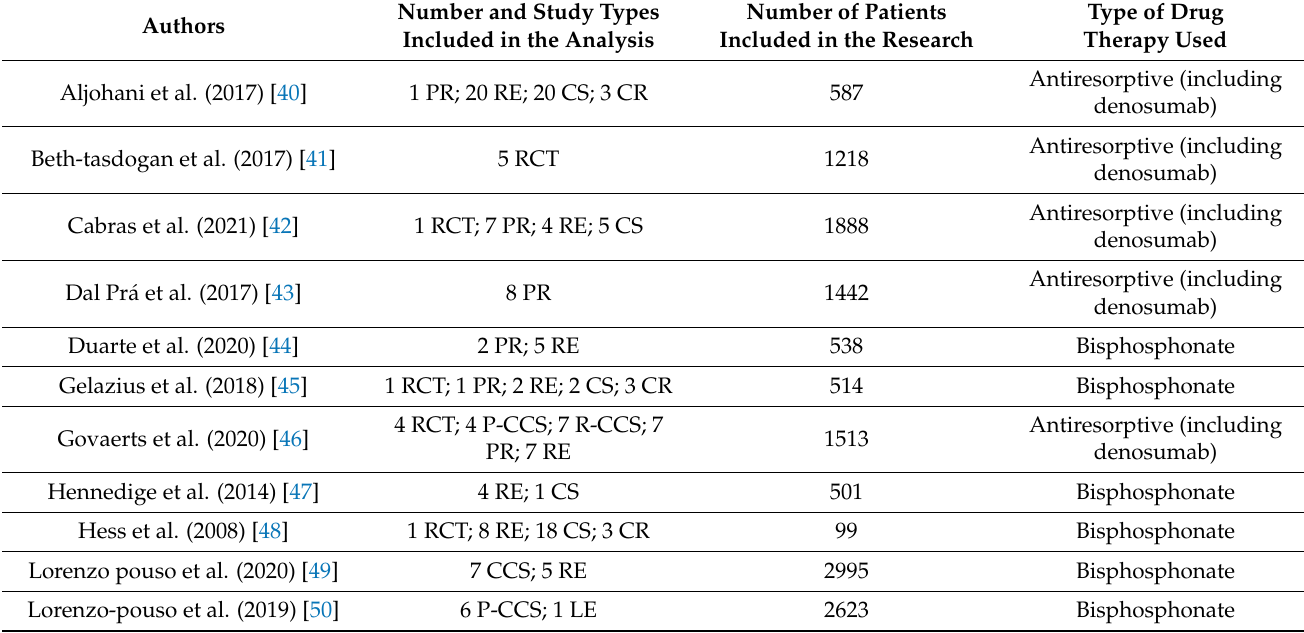
Table 3. Type of studies and patients included within respective systematic reviews. Randomized controlled trial (RCT); prospective (PR); retrospective (RE); case series (CS); case report (CR); prospective case-controlled study (P-CCS); retrospec- tive case-controlled study (R-CCS); case-controlled study (CCS); cross-sectional study (CSS); letter to the editor